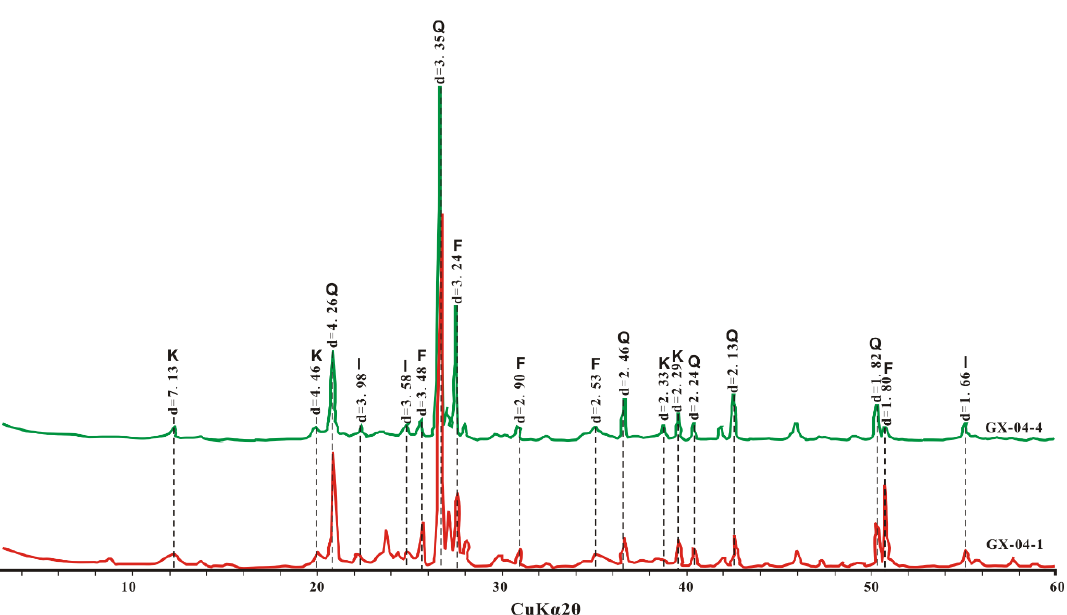
Figure 8. XRD spectra of randomly oriented bulk sample from the Ganxian Profile, I: illite-mica, K: kaolinite, Q: quartz, F: feldspars.